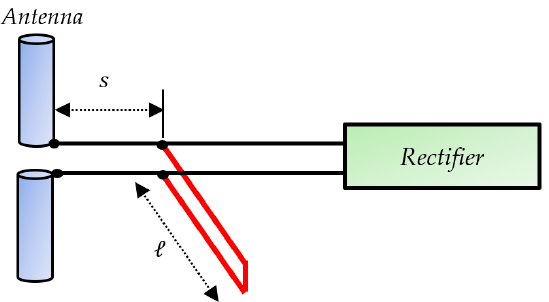
Figure 15. Shunt stub matching technique.